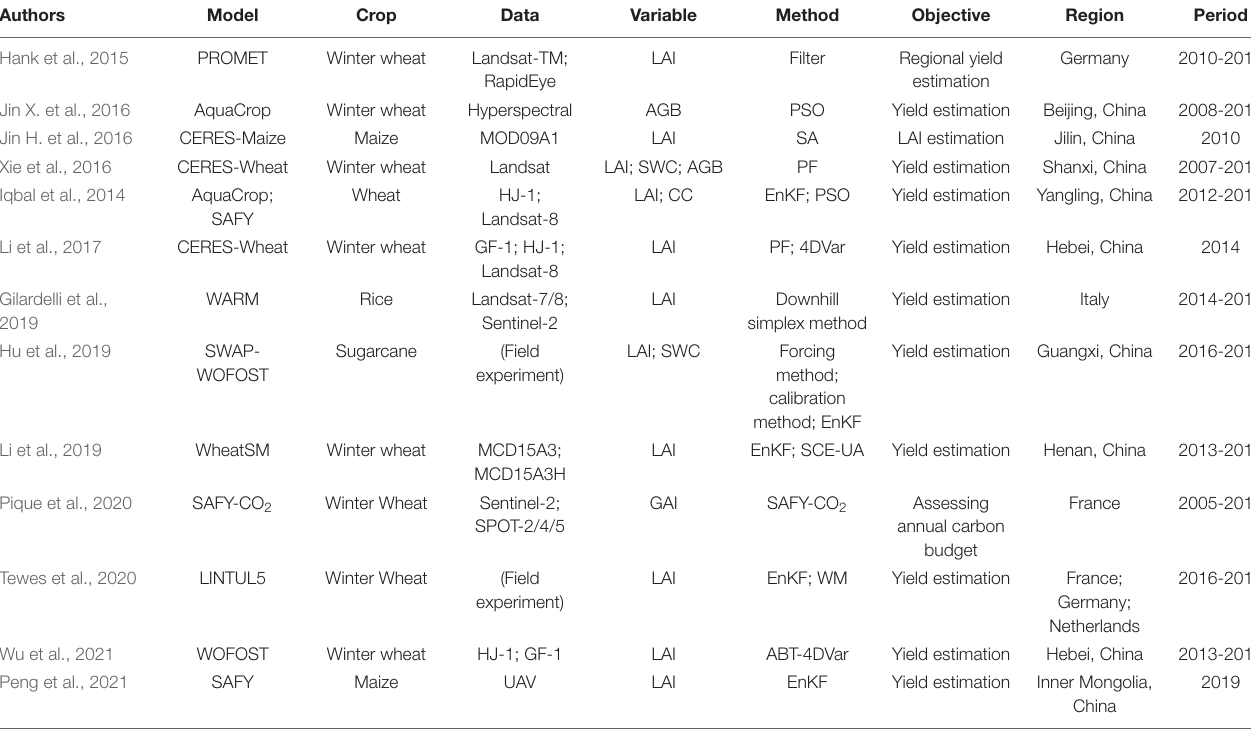
TABLE 1 | Research status of the crop model and remote sensing data